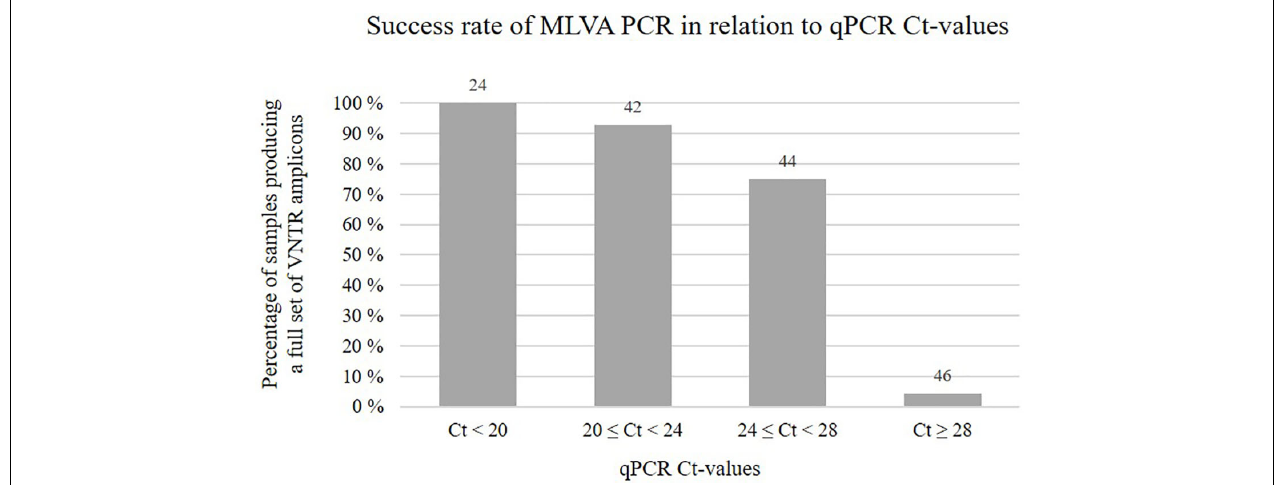
FIGURE 3 | Chart showing the percentage of samples, within different qPCR Ct-value ranges, for which MLVA PCR produced a full set of eight VNTR amplicons. Numbers above the bars indicate the total number of samples falling within each range. Notably, for some of the samples MLVA typed in this study, qPCR Ct-value measures were not